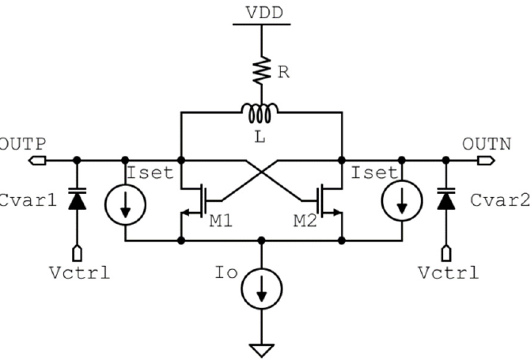
Figure 4. Schematic circuit level of the controlled oscillator with the double exponential current sources connected at the outputs.